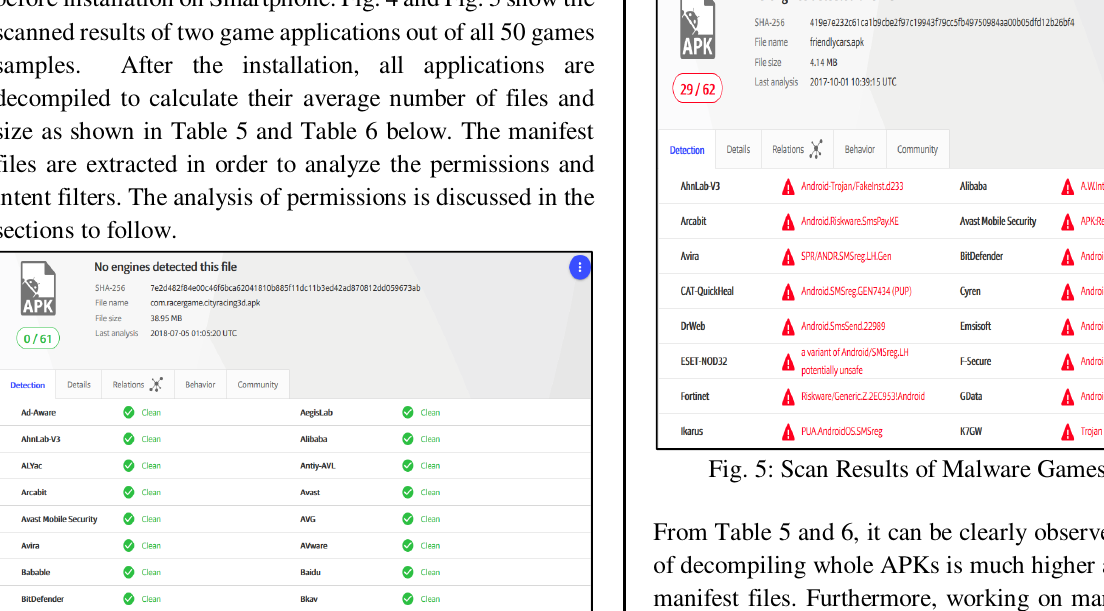
Fig. 4: Scan Results of Benign Games Samples